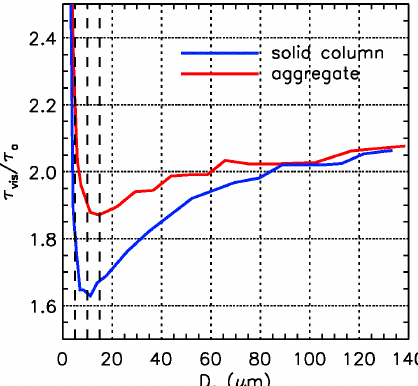
Figure 2. Simulations of the ratio between CALIOP optical depth at 532nm ( τ vis ) and IIR absorption optical depth at 12.05µm ( τ a ) at τ a = 0.25 against effective diameter D e for hexagonal solid columns (blue) and aggregates (red). Vertical dashed lines indicate D e smaller than 15µm (see